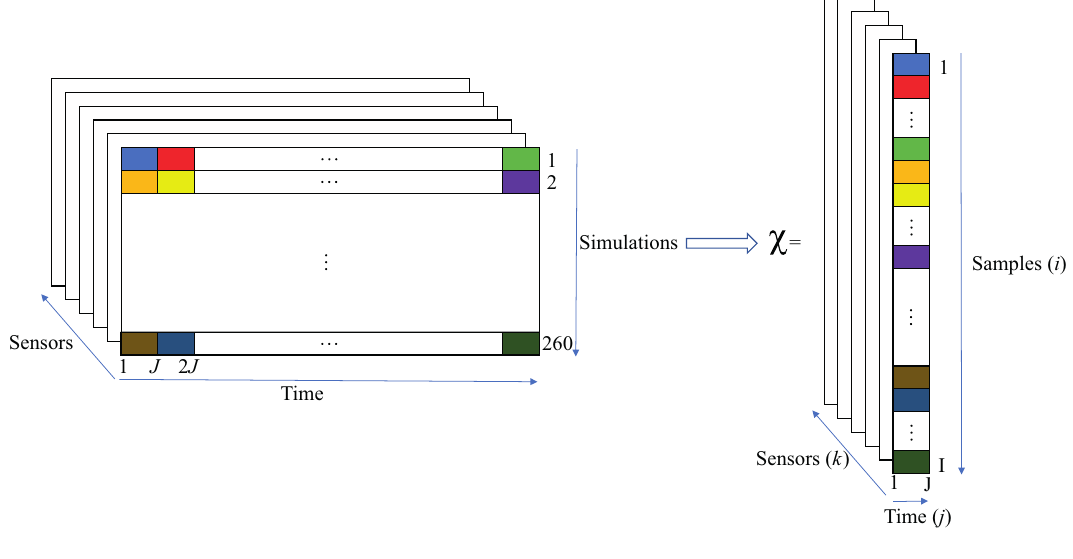
Figure 1. Reshape data from long-run simulations ( left ) into a third-order tensor X ( I × J × K ) with short time samples of J seconds ( right